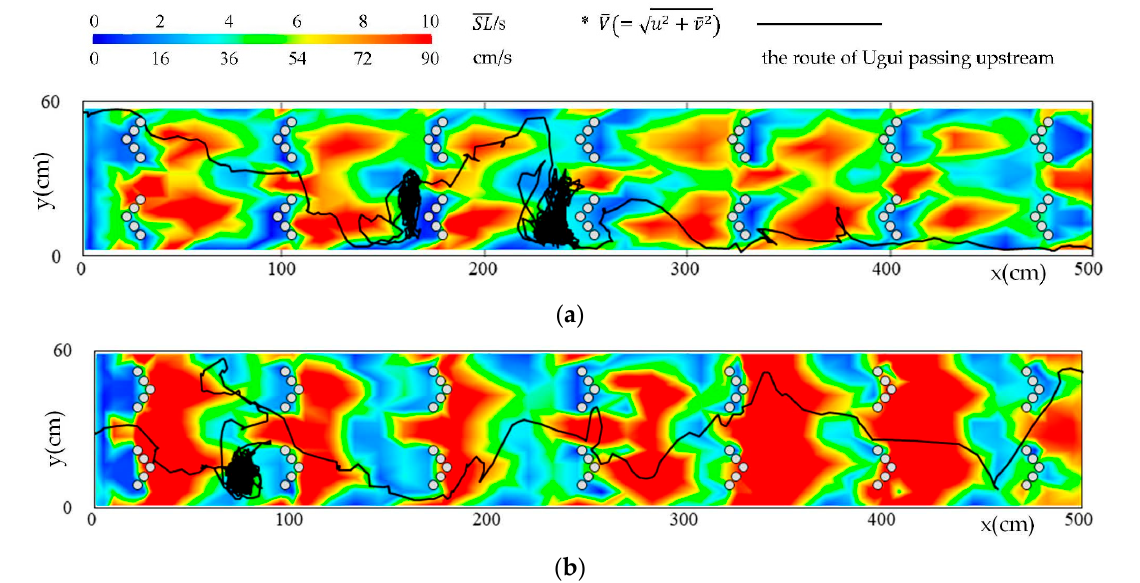
Figure 10. Flow velocity contour diagram of the fishway and the route of Ugui passing upstream in each case of this study: ( a ) Run6-cu in Case 6; ( b ) Run6-cd in Case 6.